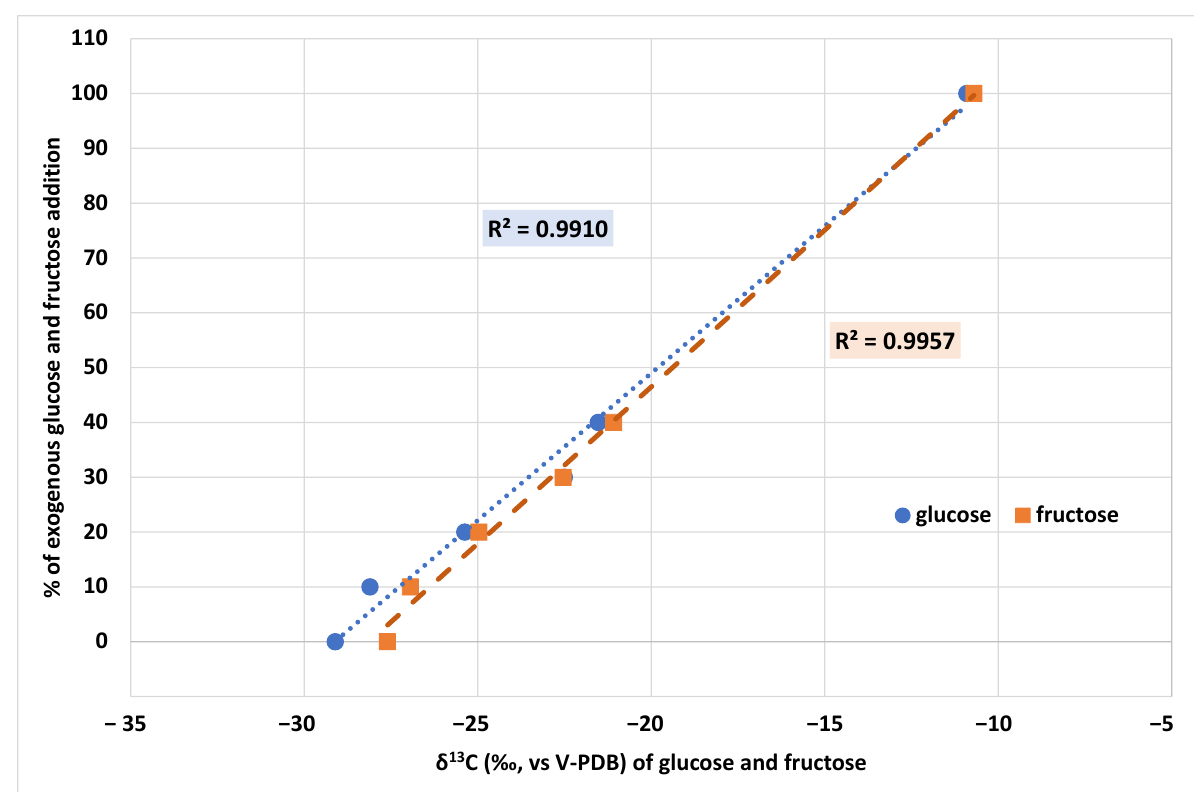
Figure 3. Variation of δ 13 C GLUCOSE and δ 13 C FRUCTOSE of an authentic grape must sample by the addition of growing % of exogenous glucose and fructose.